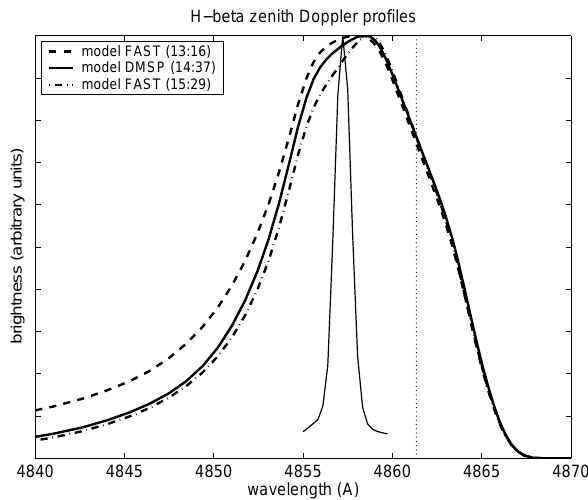
Fig. 17. Comparison of three different model runs corresponding to the best fit to measured profiles at times of satellite